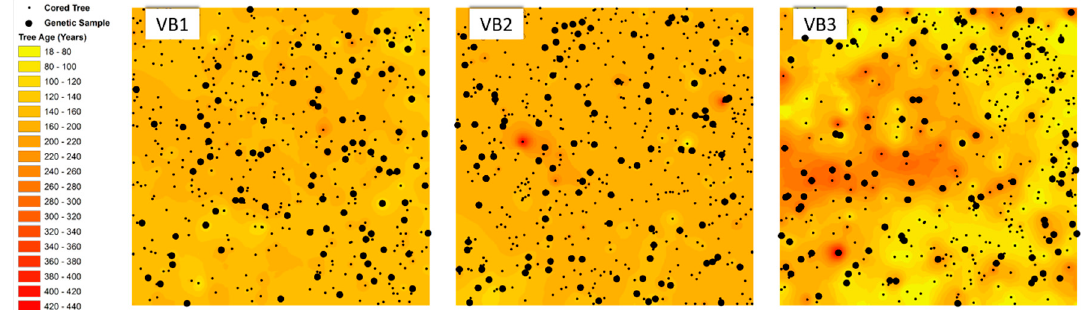
Figure 1. Sampling design adopted in the three 1-ha permanent plots (VB1, VB2 and VB3). Small dots represent mapped trees (DBH > 7.5 cm) while large dots represent trees sampled for genetic analyses. IDW interpolated age data are used as background.